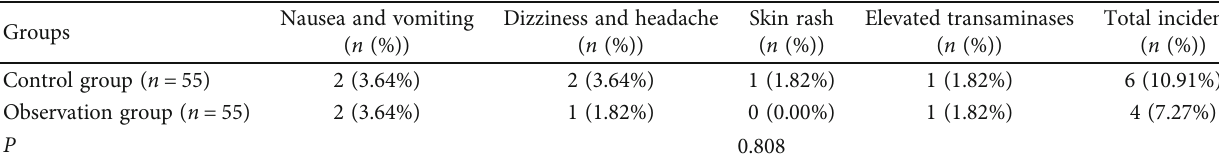
Table 7: Incidence of adverse reactions during treatment in both groups.